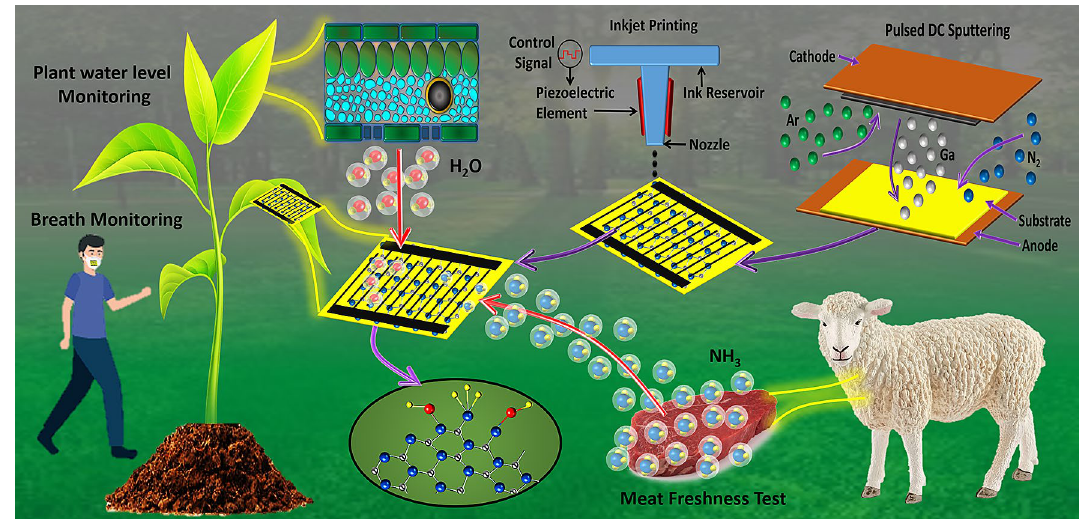
Figure 1. Schematic illustration of fabrication process of humidity